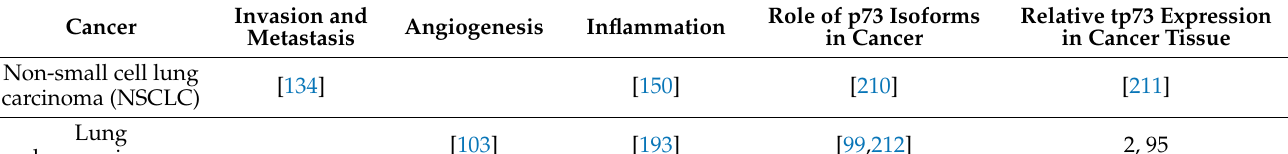
Table 1. The cancer hallmarks and p73 functions in specific cancers. The table structure: The rightmost column rep- resents the Tp73 expression in tumour tissue (Tp73Tum) in comparison with the normal tissue (Tp73Norm) as a